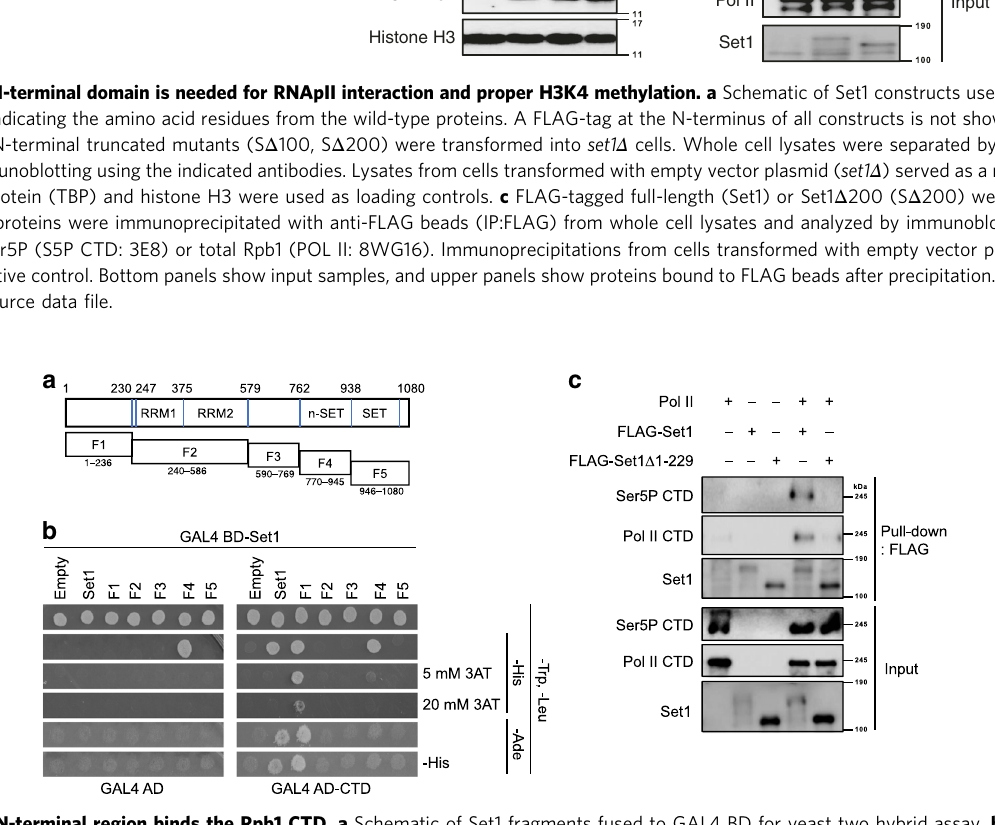
Fig. 2 The Set1 N-terminal region binds the Rpb1 CTD. a Schematic of Set1 fragments fused to GAL4 BD for yeast two hybrid assay. b GAL4 BD – Set1 fusions were co-expressed with GAL4 AD – CTD in Y2H strain PJ69-4A, which has both HIS3 and ADE2 reporters for Gal4 activation. Plasmid expressing only the GAL4 AD was used as a negative control. Cells were grown for 2 days on synthetic complete (SC) media plates lacking the indicated amino acids. Five or 20 mM of 3-aminotriazol (3AT) was added to media as indicated to increase HIS3 selection stringency. Cells were also replica plated to -Ade or -Ade, -His plates to monitor the ADE2 reporter. c COMPASS containing FLAG-tagged Set1 or a derivative lacking residues 1 – 229 was incubated with puri fi ed RNApII. Bottom panels show input samples, and upper panels show proteins bound to FLAG beads after precipitation. Source data are provided as a Source data fi le.